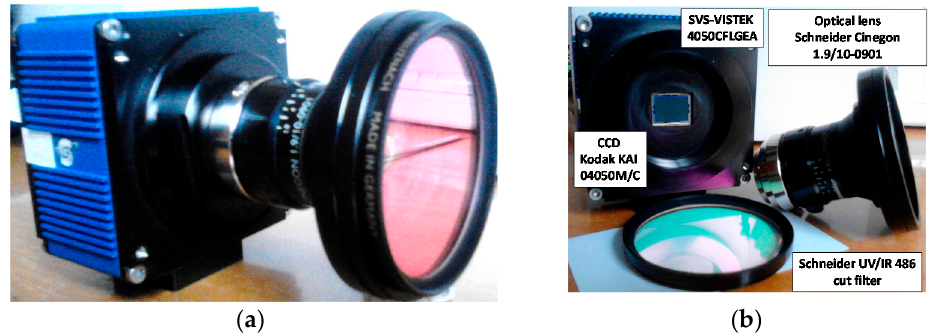
Figure 13. Charge Coupled Device (CCD) sensor, lens and UV/IR cut filter: ( a ) assembled; ( b ) separated.